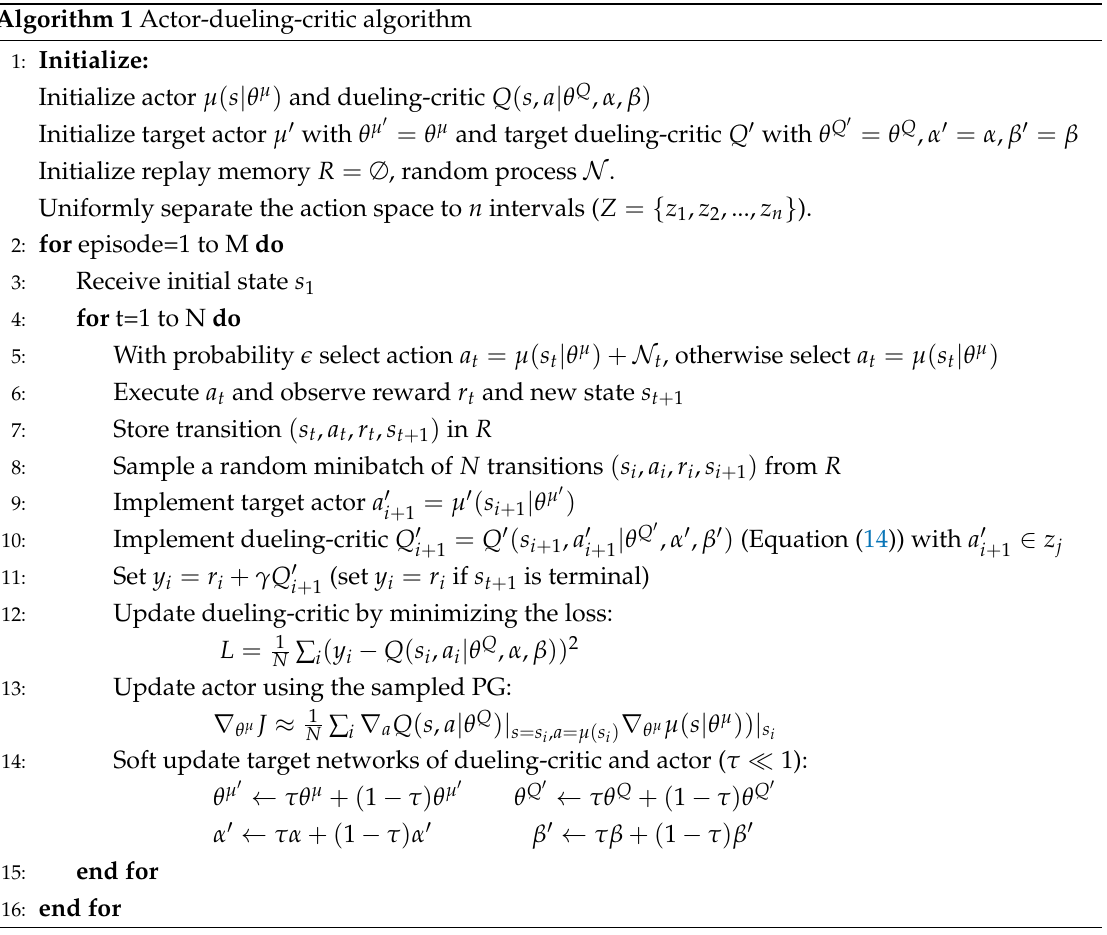
Algorithm 1 Actor-dueling-critic